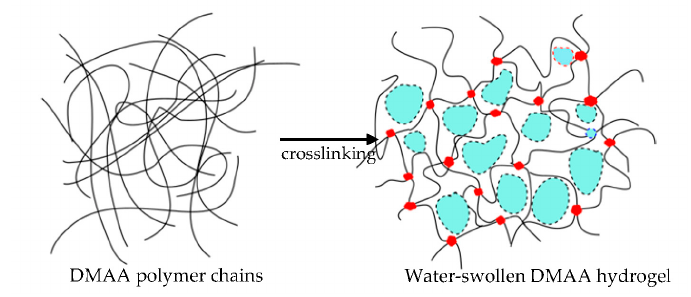
Figure 2. A schematic showing DMAA polymer chains and self-crosslinked flexible hydrogel structure with crosslinking points (red) and water molecules (blue) entrapped within its network.